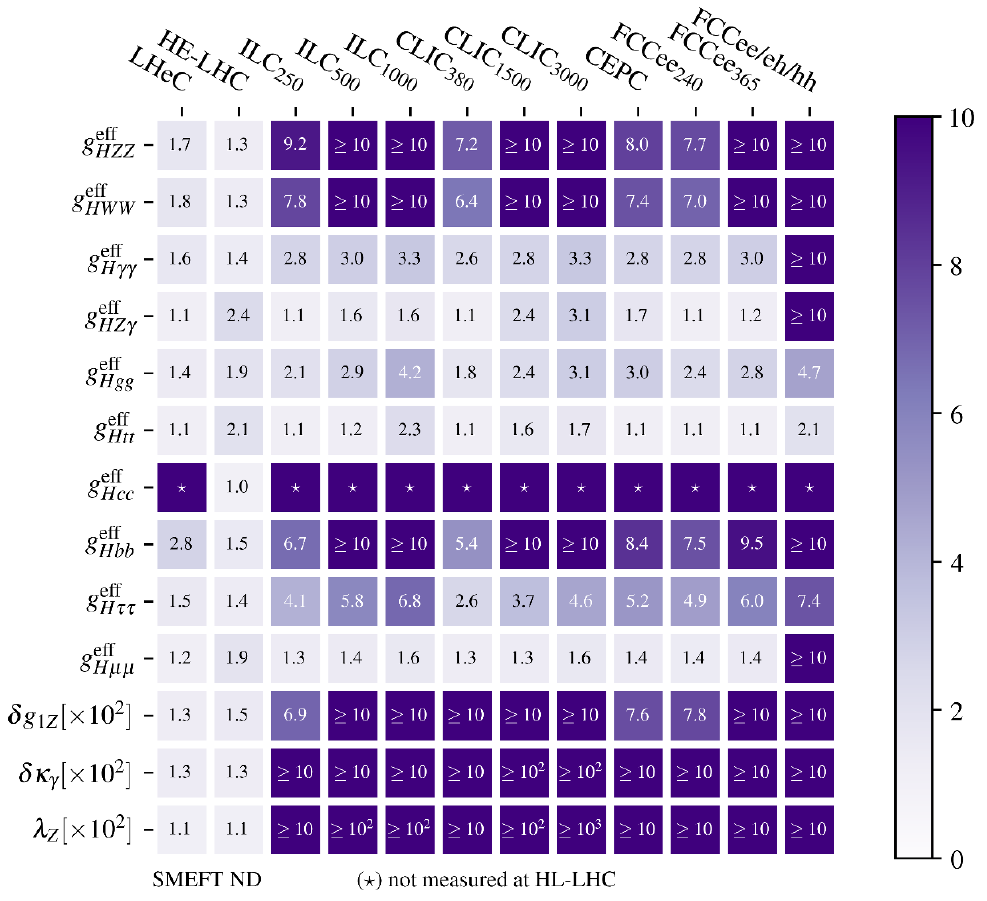
Figure 20 . Graphic comparison of the improvement with respect to HL-LHC in the SMEFT-ND